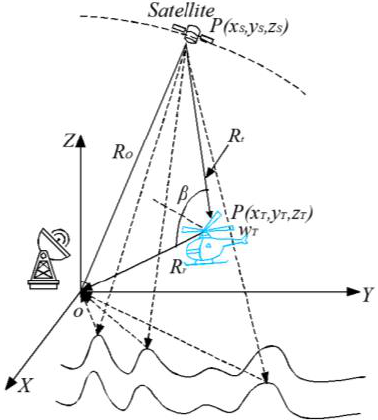
Figure 1. PBR geometry with the GNSS illuminator.